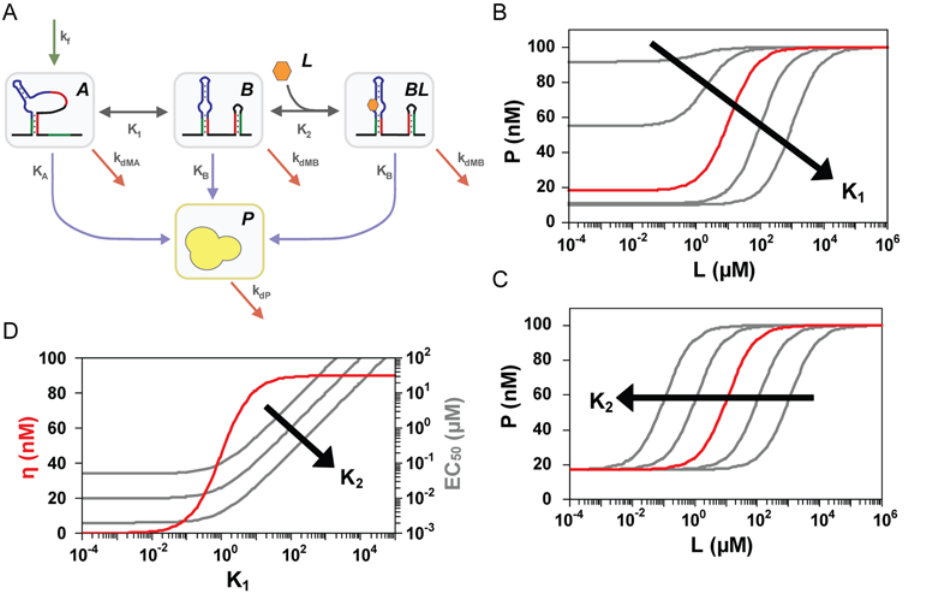
Figure 2. Thermodynamically-driven riboswitches display similar tuning properties. (A) Simplified molecular description that captures the three riboswitch regulatory mechanisms in the thermodynamically-driven regime. K 1 is the conformational partitioning constant (k 1 9 /k 1 ) and K 2 is the aptamer association constant (k 2 /k 2 9 ). Coloring is the same as in Figure 1B–D. K A and K B reflect the regulatory activity of conformations A and B, respectively, and are specific to each regulatory mechanism: translational repression (k PA , k PB ), transcriptional termination (k P ? k MA /k M , k P ? k MB /k M ), and mRNA destabilization (k P , k P ). (B) K 1 affects both basal levels and EC 50 . (C) K 2 only affects EC 50 . Parameter values for red response curves: K 1 =10; K 2 =1/ m M; K A =10 2 3 /s; K B =10 2 2 /s; k f =10 2 11 M/s; k dP =10 2 3 /s; k dMA =k dMB =10 2 3 /s. (D) Biased conformational partitioning toward conformation B maximizes the dynamic range ( g ) at the cost of increased EC 50